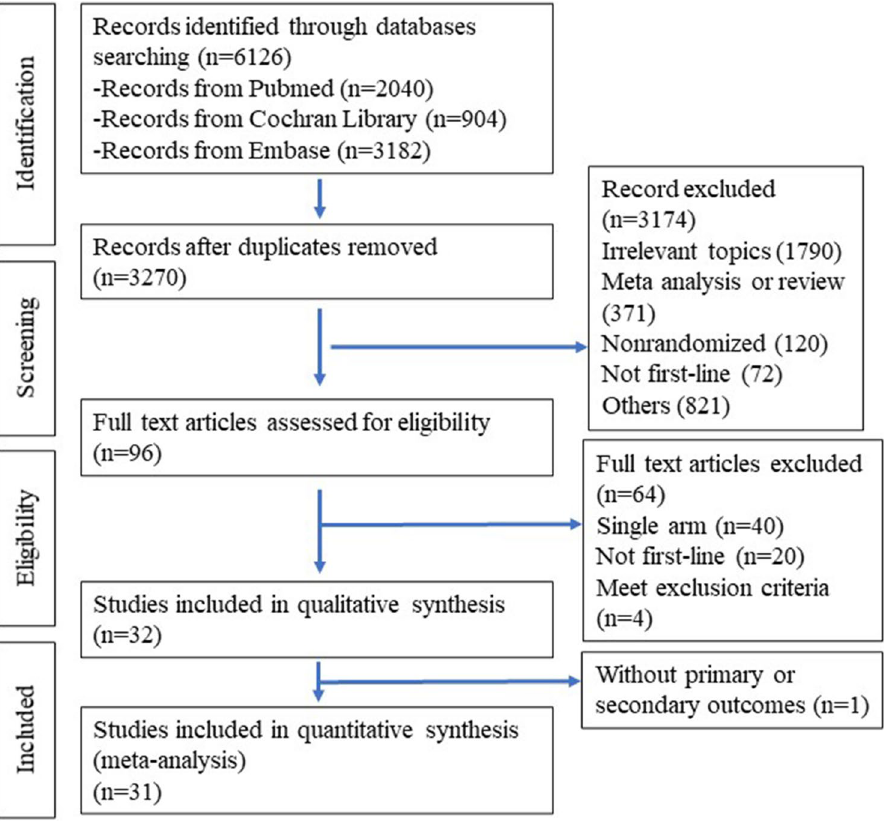
Figure 1. Flowchart of the study selection